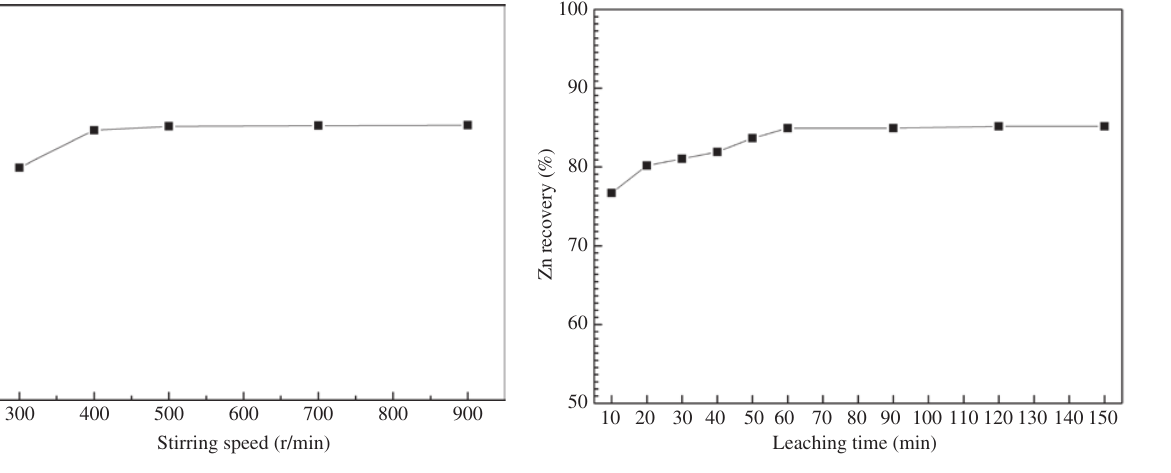
Figure 8: Effects of different stirring speeds on the zinc recoveries of the roasted ores.